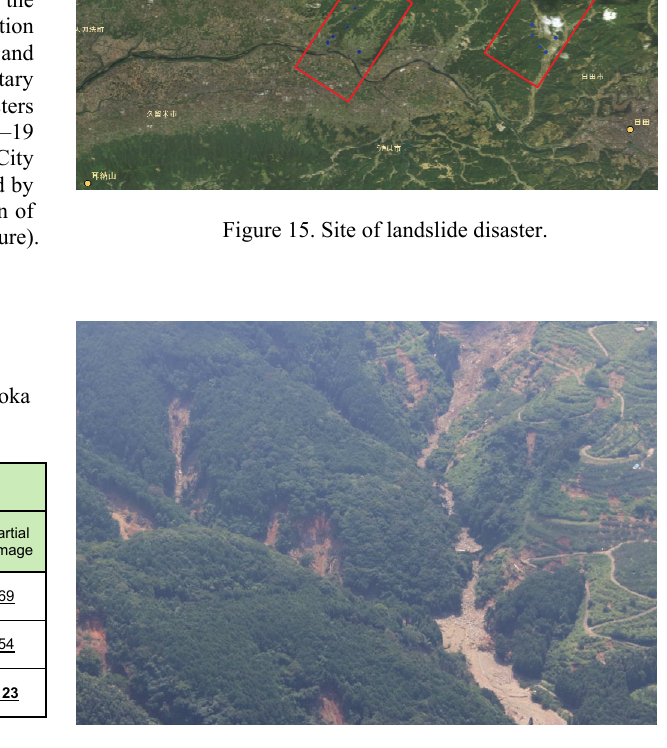
Figure 16. Sediment disasters in Asakura City (1).